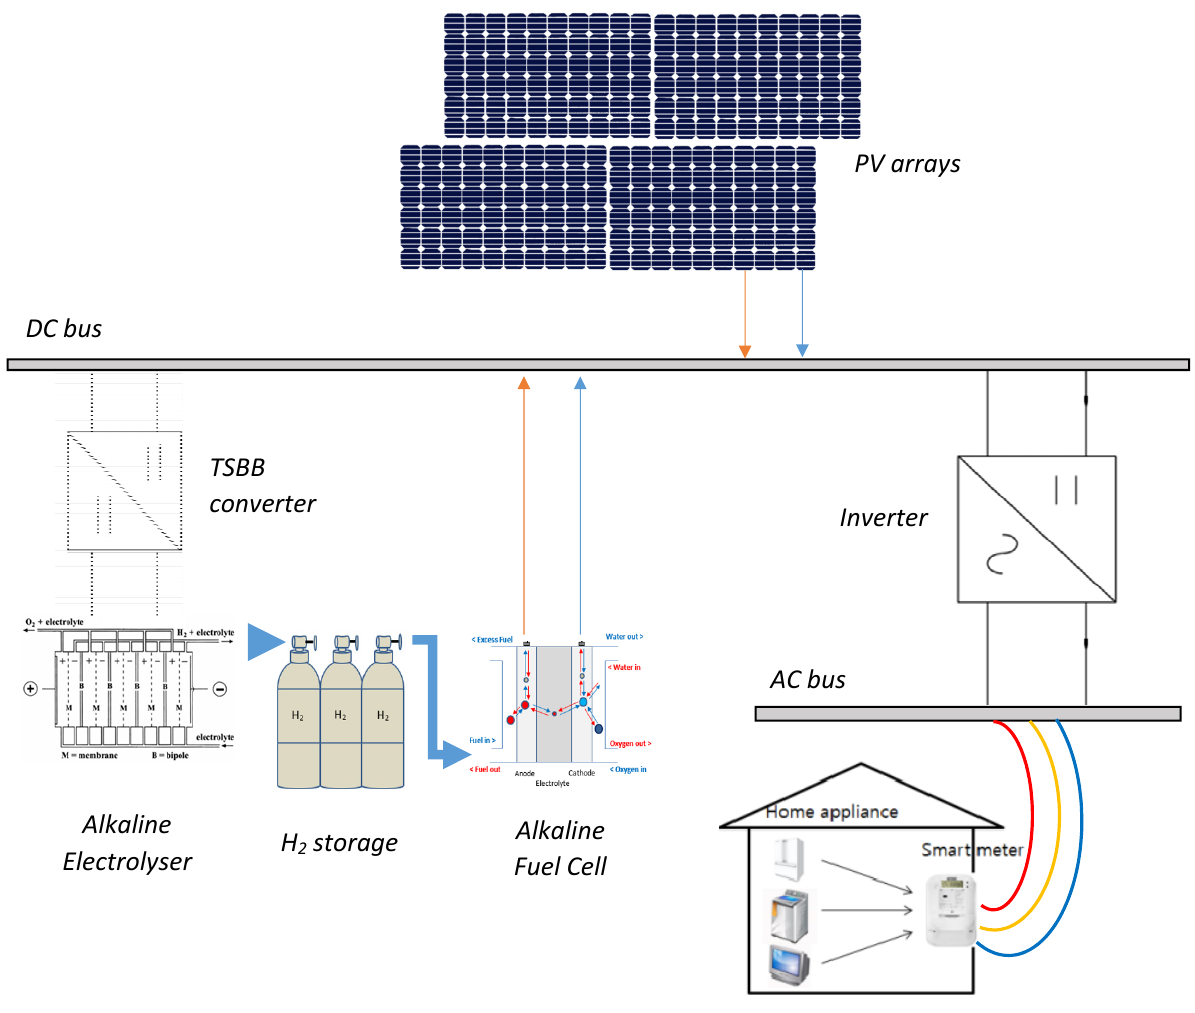
Figure 2. Proposed hybrid PV power-to-hydrogen